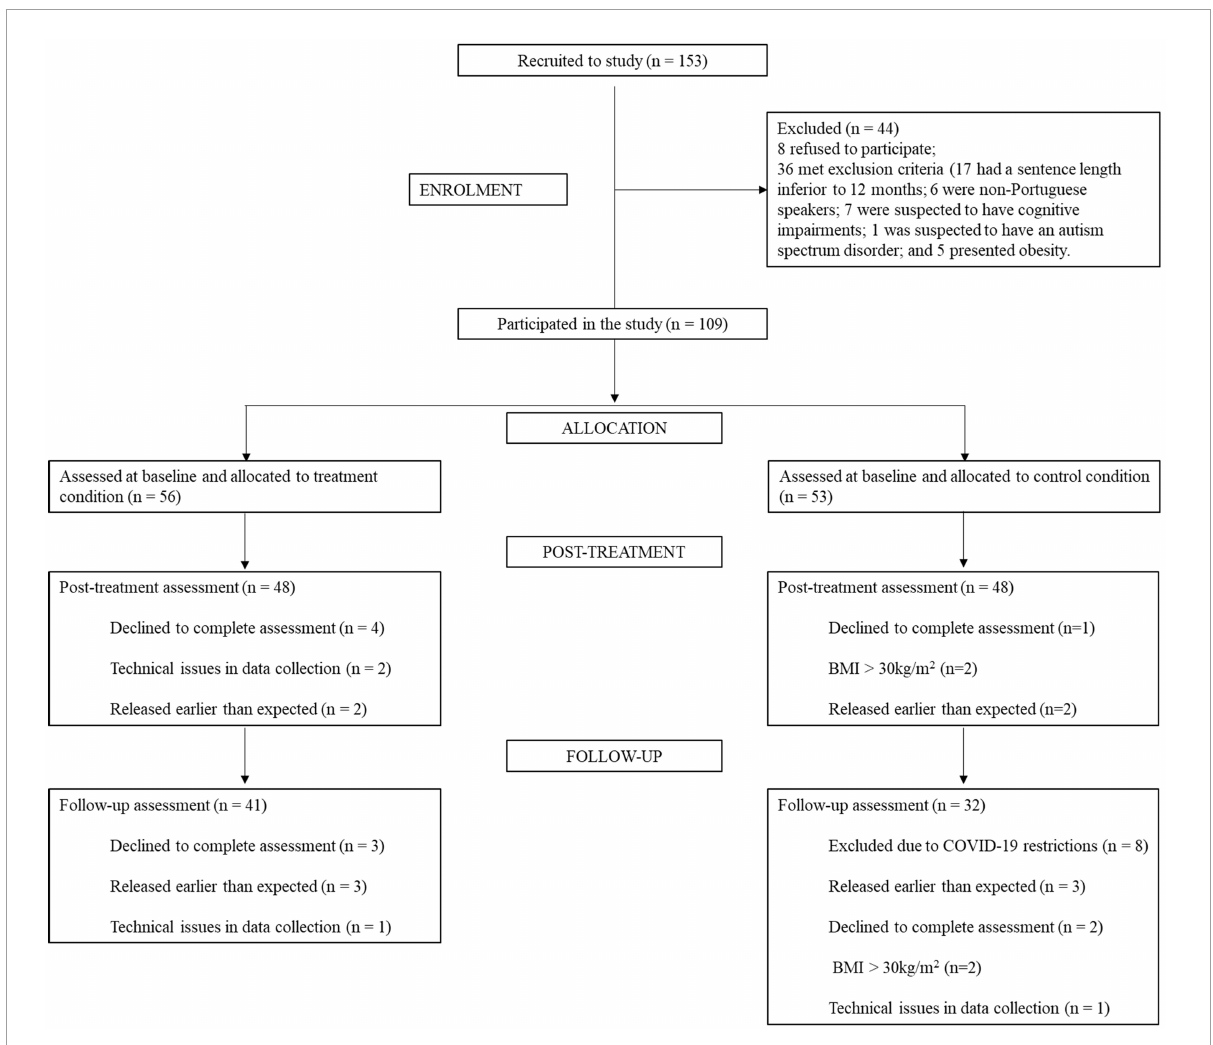
FIGURE2 Flowchart of detained youth